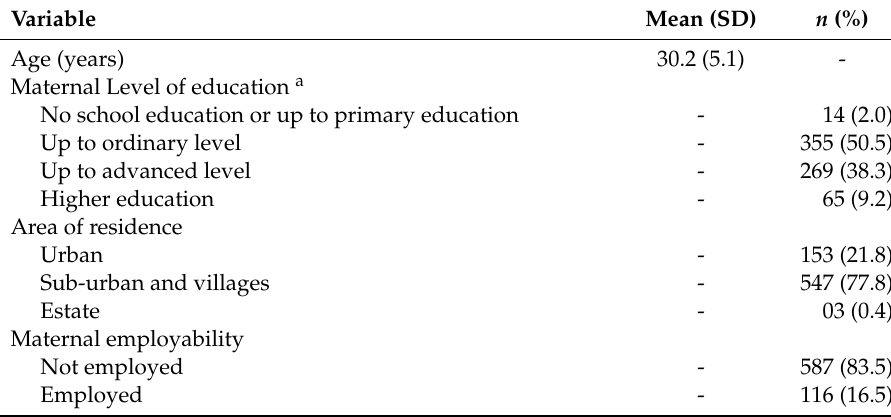
Table 1. Characteristics of participants ( n =